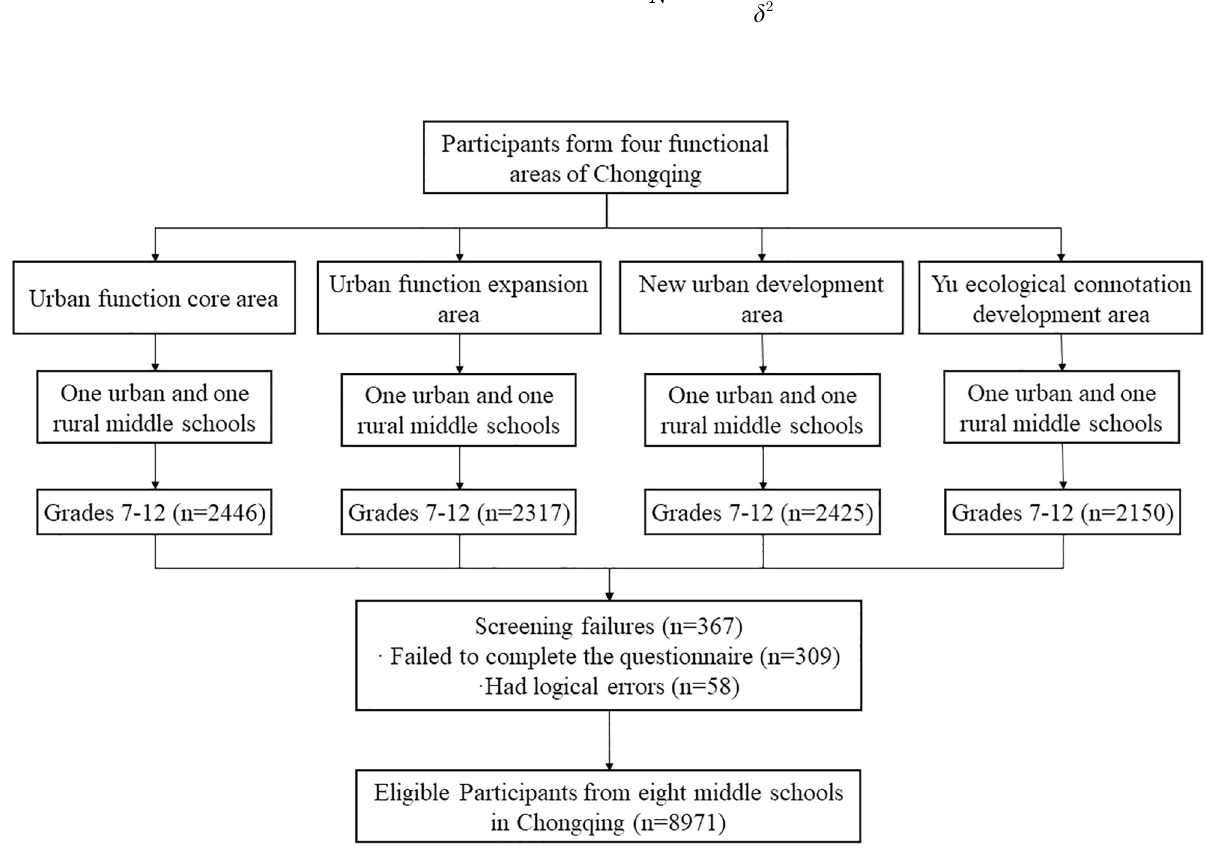
Fig 1. Stratified cluster sampling was adopted to identify participants in this